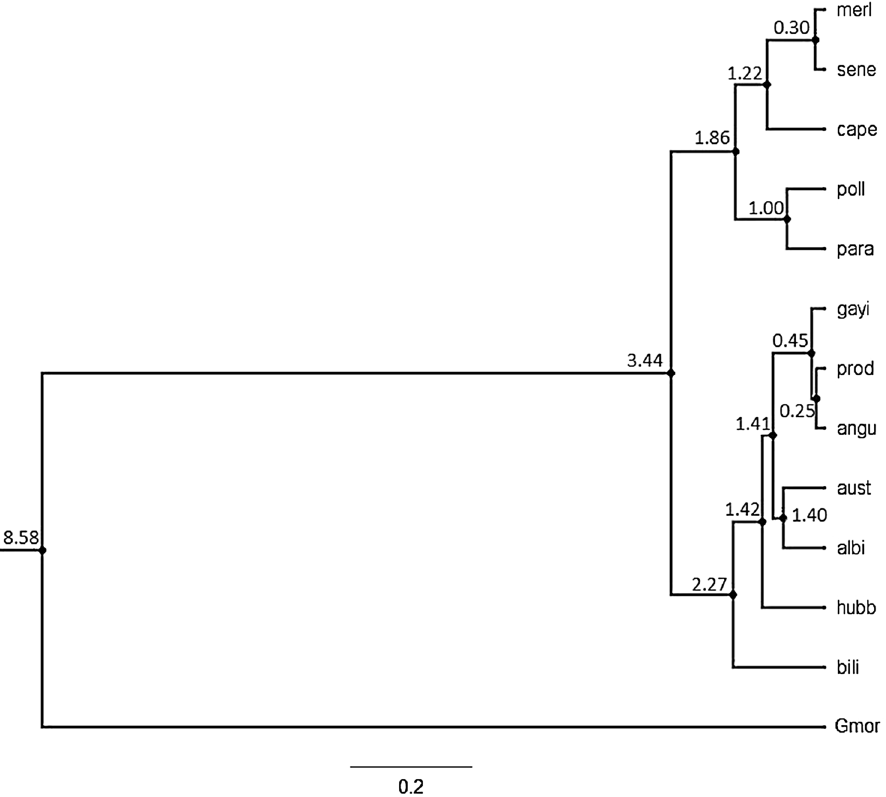
Figure 4. Bayesian reconstruction of genus Merluccius spp. on sequence variation of cyt b majority haplotypes (GTR + G substitution model) using BEAST v1.8.4 85 . Divergence time is given in MYA on nodes as calculated upon a 2% mutation rate averaged among 26 pairs of major intraspecific phylogroups of fishes 40 . Gmor corresponds to the outgroup Gadus morhua . Scale bar indicates the No. of nucleotide substitutions per 100 DNA residues. Sample codes are given in Table